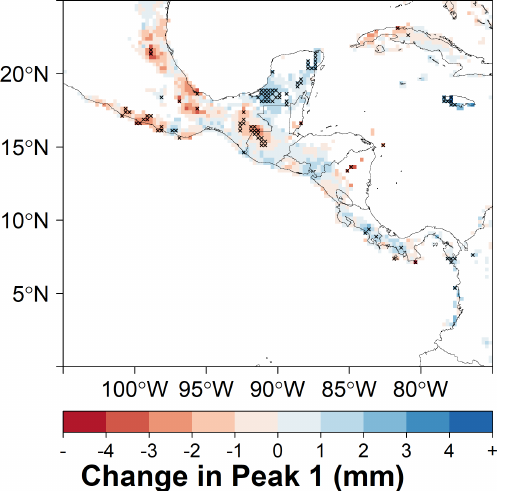
Figure A3. The change in magnitude of the first peak MSD be- tween the early (1981–2000) and late (2001–2020) periods. Grid cells marked with an “X” show statistically significant changes.